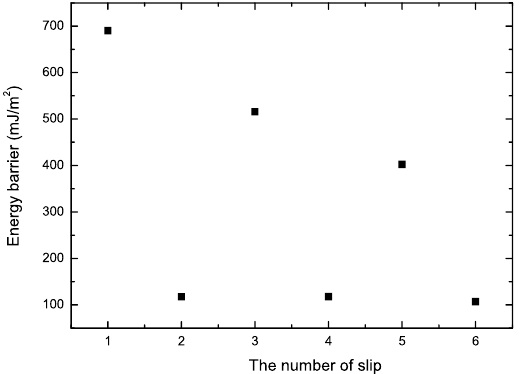
Figure 2. Energy barriers during various slips of Shockley partial dislocation of 1/6 1210 < > on Ti 1010 { } planes.